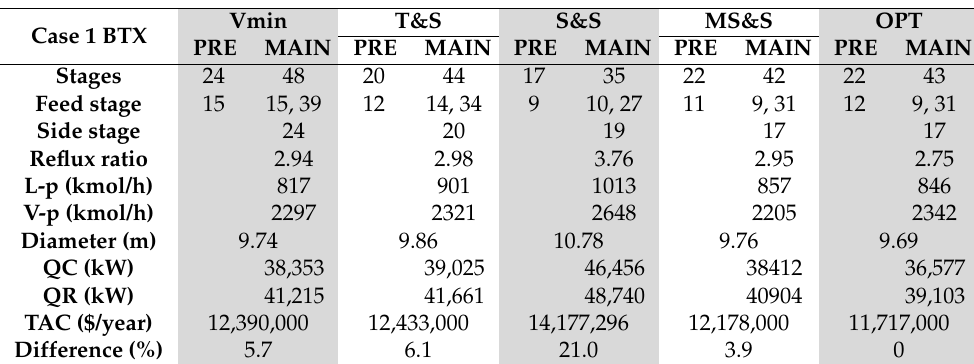
Table 2. Results for the Benzene, Toluene, and o-Xylene